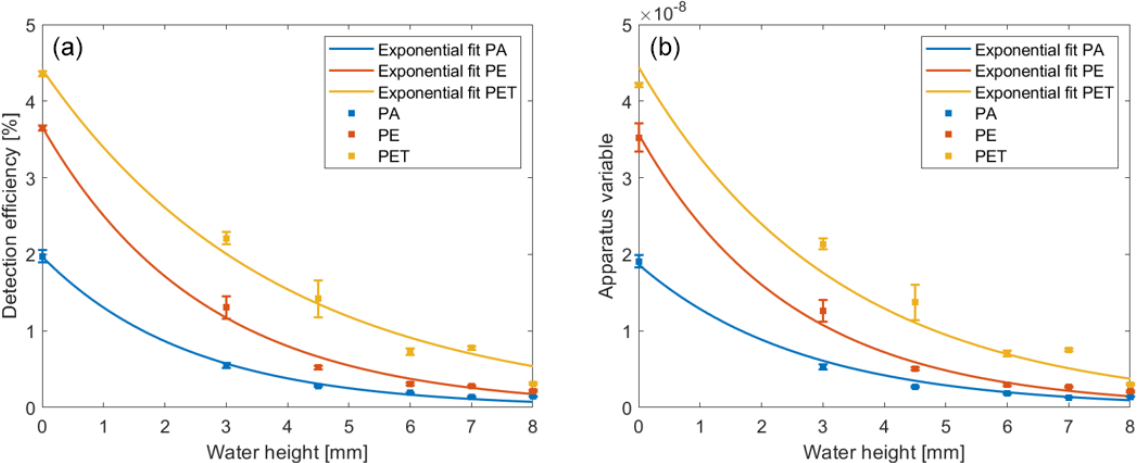
Figure 4. Representation of the fitting curves for the decreasing detection efficiency (a) and apparatus variable (b) . Table 2. Determined coefficients a , b and R 2 of the exponential fit for detection efficiency DE and apparatus constant DE A .